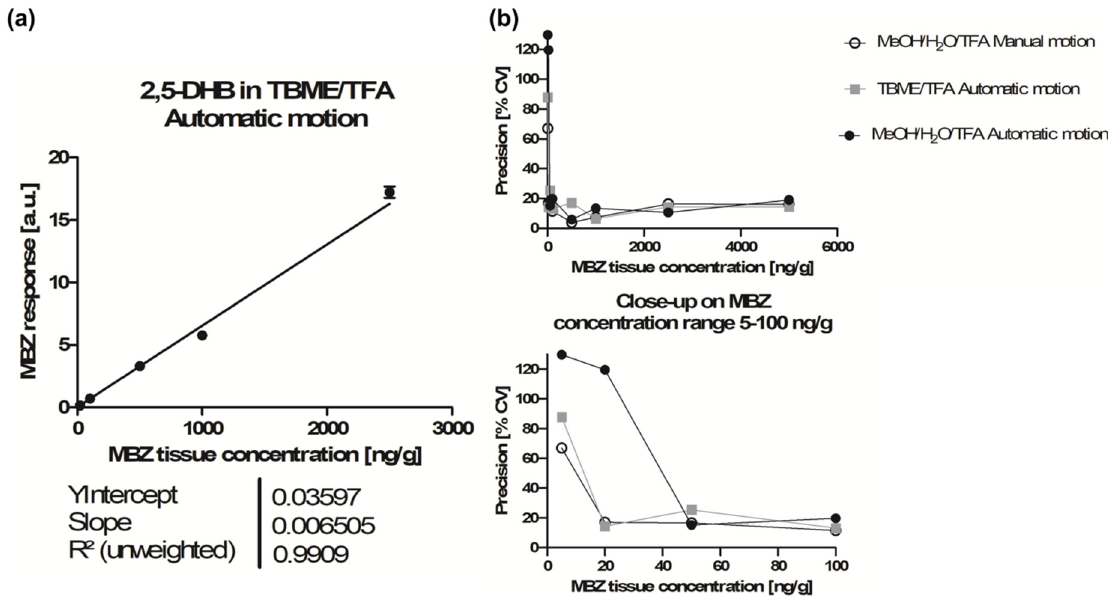
Figure 5. ( a ) Calibration curve obtained for mebendazole (MBZ) quantification in tissue using the MALDI matrix 2,5-dihydroxybenzoic acid (2,5-DHB) dissolved in tert-butyl methyl ether (TBME)/trifluoroacetic acid (TFA) 100:0.1 ( v / v ). ( b ) Precision graphs for calibration points using 2,5-DHB in MeOH/H 2 O/TFA 50:50:0.1 ( v / v / v ) and manual or automatic motion, or using 2,5-DHB in TBME/TFA 100:0.1 ( v / v ).